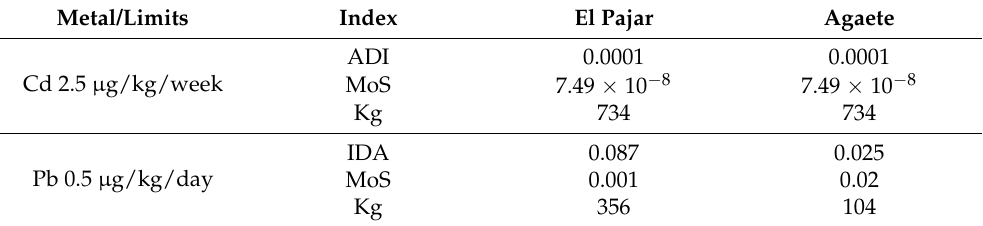
Table 7. Risk assessments (Pb, Cd) for muscle samples, the ADI (Estimated Daily Intake), MoS (Margin of Safety), and the amount in kg of muscle that would have to be consumed every day throughout life for it to be harmful to the human being have been